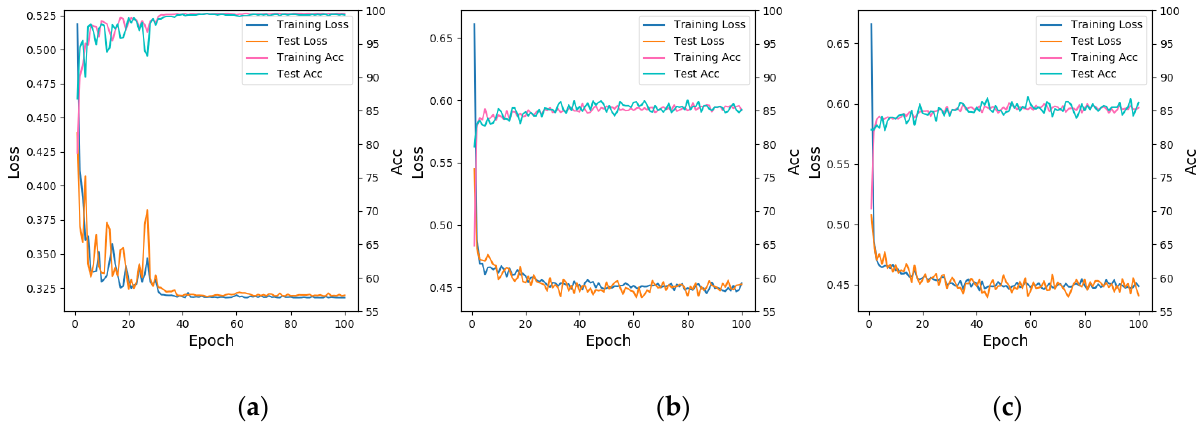
Figure 8. Loss and accuracy change curve. ( a ) Training process of model 1; ( b ) Training process of model 2; ( c ) Training process of model 3.